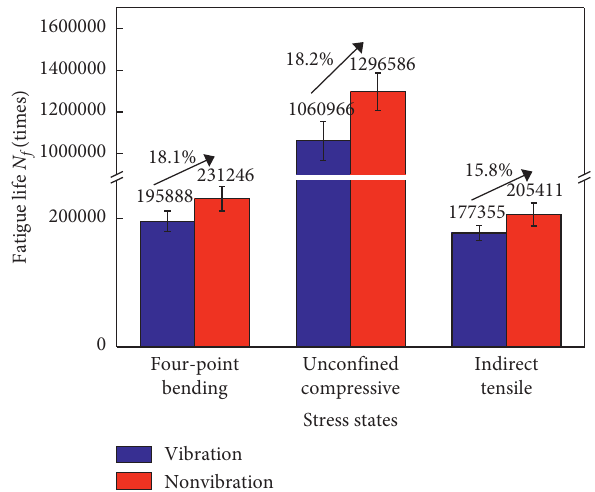
Figure 11: Standard fatigue life of vibratory and nonvibratory mixed specimens under different stress states.